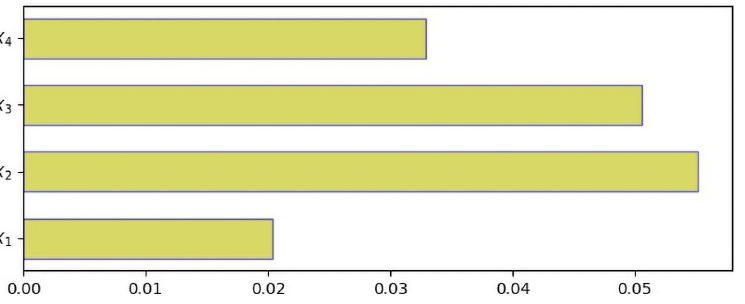
Fig 6. Gradient values to estimate variables’ prediction contributions. Note. X 1 = performance; X 2 = expectations; X 3 = disconfirmation; X 4 =